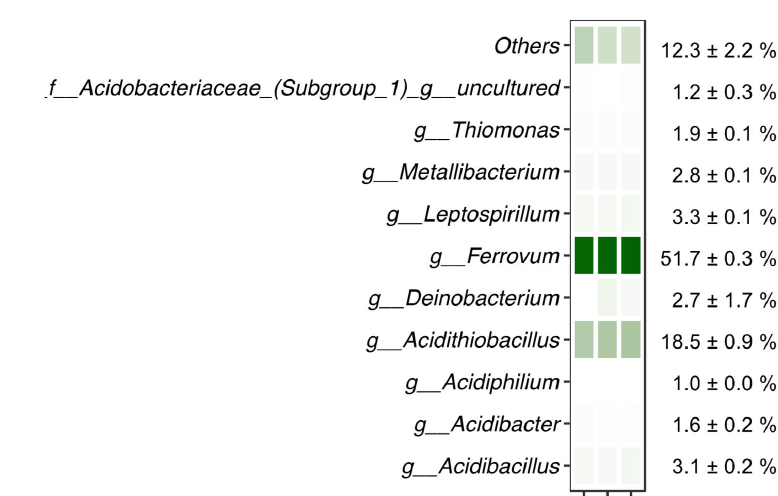
Figure 8. Microbiological analysis of water underlying a floating mineral film in Rio Tintillo showing relative abundance of sequenced reads assigned to taxa indicated on the left; f__: family, g__: genus. Relative abundance is shown per replicate on a color scale (white–green representing minimum to maximum relative abundance, respectively). Average relative abundance is indicated on the right.